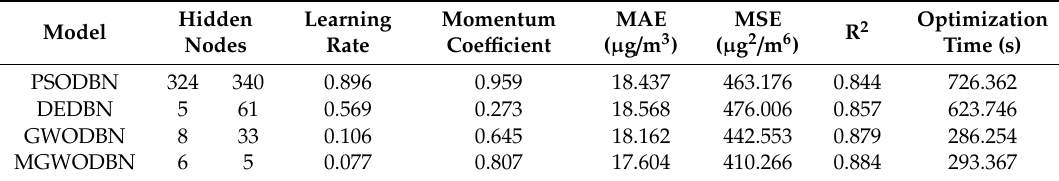
Table 2. Structures of deep belief network (DBN) based on the optimization algorithms. MAE: